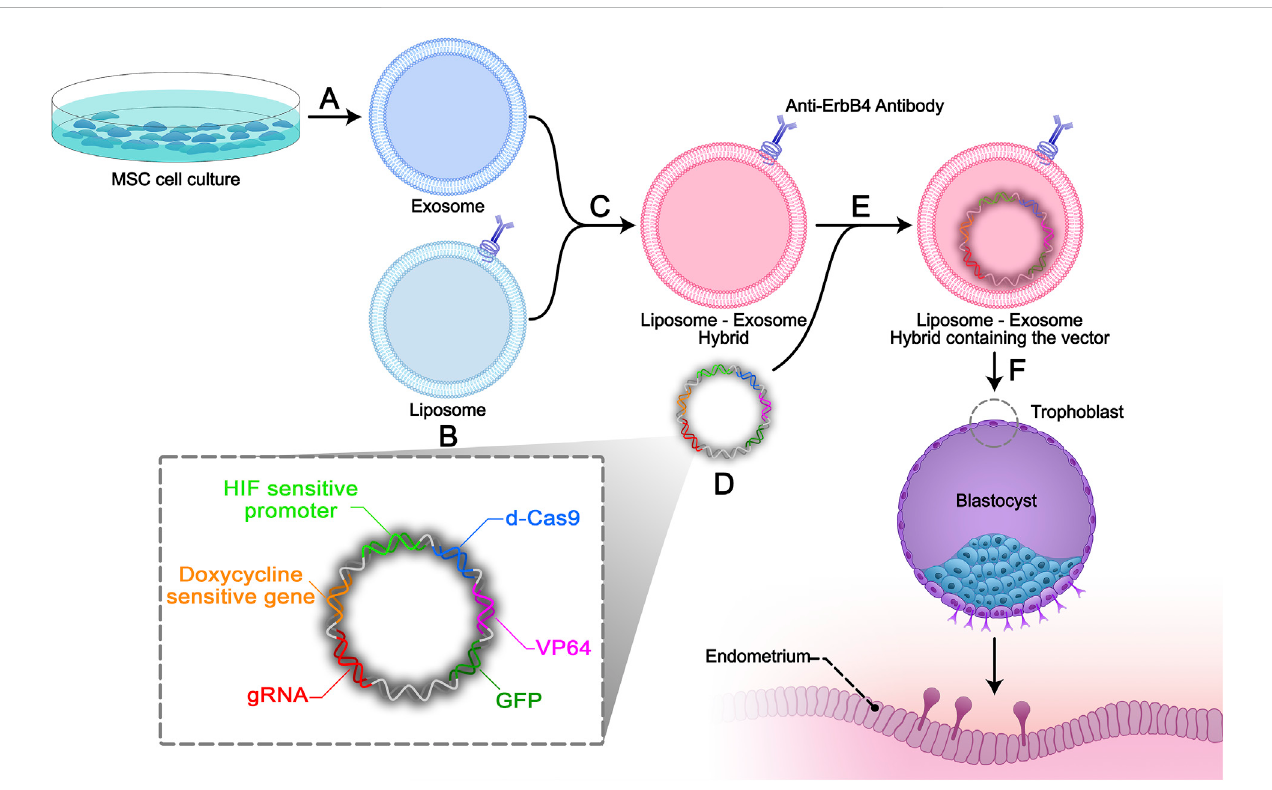
FIGURE 2 Study design. (A) Isolation and characterization of Mesenchymal stem cell-derived exosomes (MSC exosomes) by the ultra-centrifuge method. (B) Antibodies against ErbB4 conjugate on the surface of constructive liposomes. (C) Exosomes derived from end-MSCs will be incubated with the targeted liposomes to make exosome-liposome hybrids. (D) Non-viral S/MAR episomal vector will be constructed containing: sgRNA, HIF-1 sensitive promotor (evidence), dCas 9, VP64, GFP gene sequences, doxycycline sensitive gene, and ribosomal skipping 2A sequences between the genes. (E) Electroporation will be used to encapsulate the designed episomal S/MAR vector into the hybrid. (F) The liposome-exosome hybrids will be added to the trophoblast cell media and the episomal vector will speci fi cally enter the